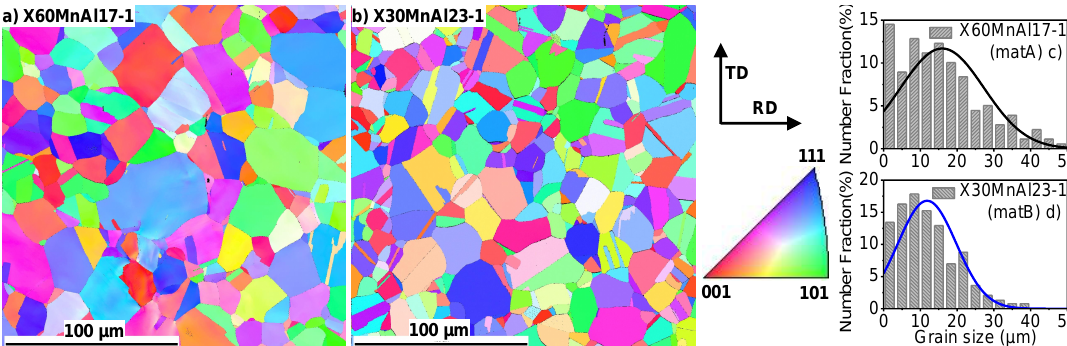
Figure 2. The EBSD inverse pole figure (IPF) maps of the undeformed samples showing grain size and orientations: ( a ) X60MnAl17-1, ( b ) X30MnAl23-1. Grain size fitted using normal distribution function shown in: ( c ) X60MnAl17-1, ( d ) X30MnAl23-1; microstructures of both alloys is completely austenite ( γ ); the average grain size of X60MnAl17-1 is 16.0 µm and X30MnAl23-1 is 12.0